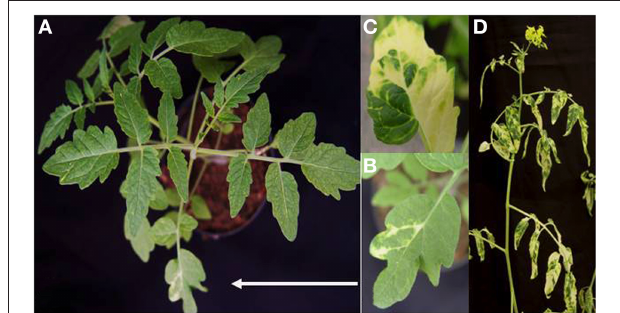
FIGURE 2 | Phenotype of silencing of ChI I gene in S. peruvianum. (A) Phenotype of leaf bleaching at 10 dpi. (B) Close up of a bleached leaf at 10